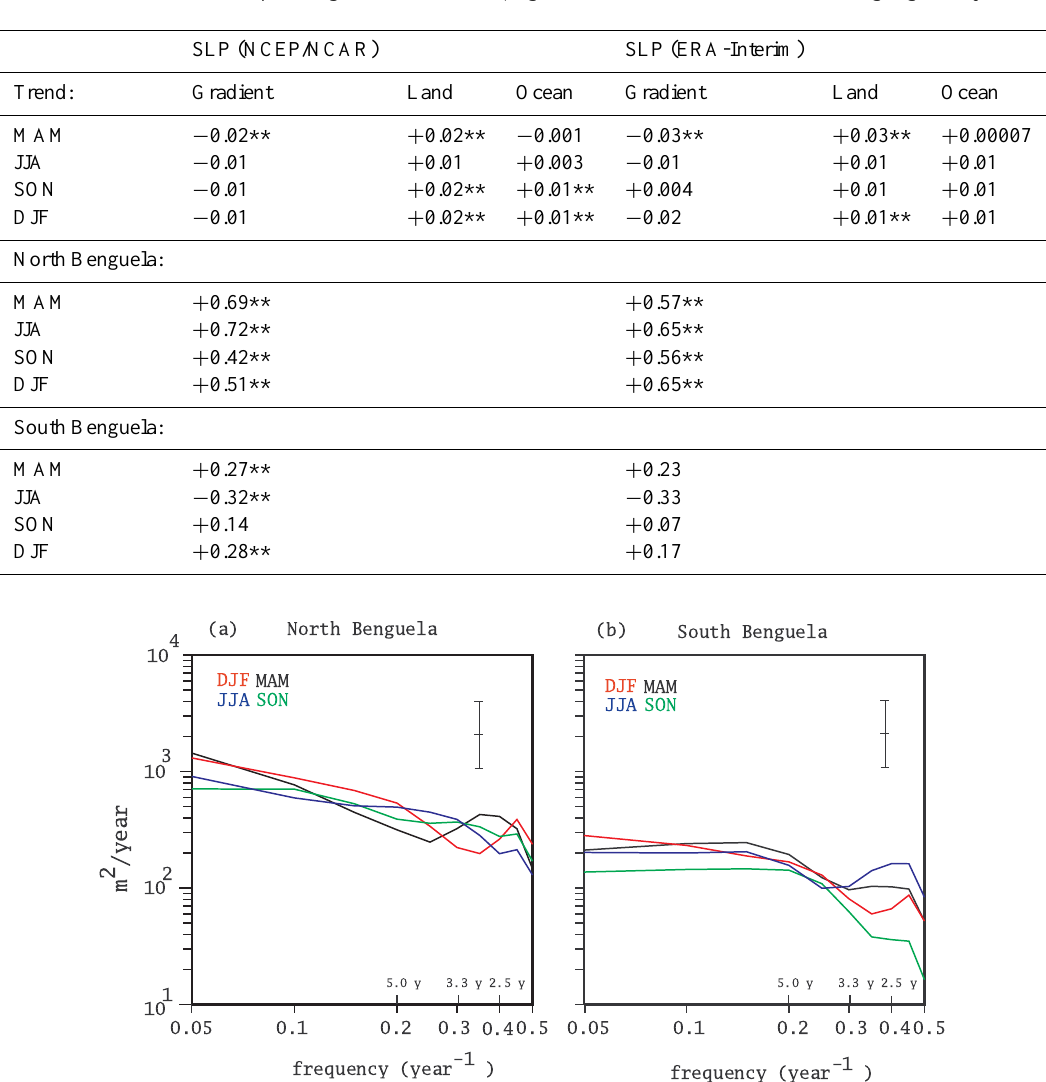
Table 4. Sea level pressure over land, over ocean, and gradient (ocean: 20 ◦ W–10 ◦ E, 15–35 ◦ S; land: 12–25 ◦ E, 10–20 ◦ S) trend (in hPayr − 1 ) and its correlation coefficients with the upwelling index of STORM, significant correlations and trends are highlighted by **.